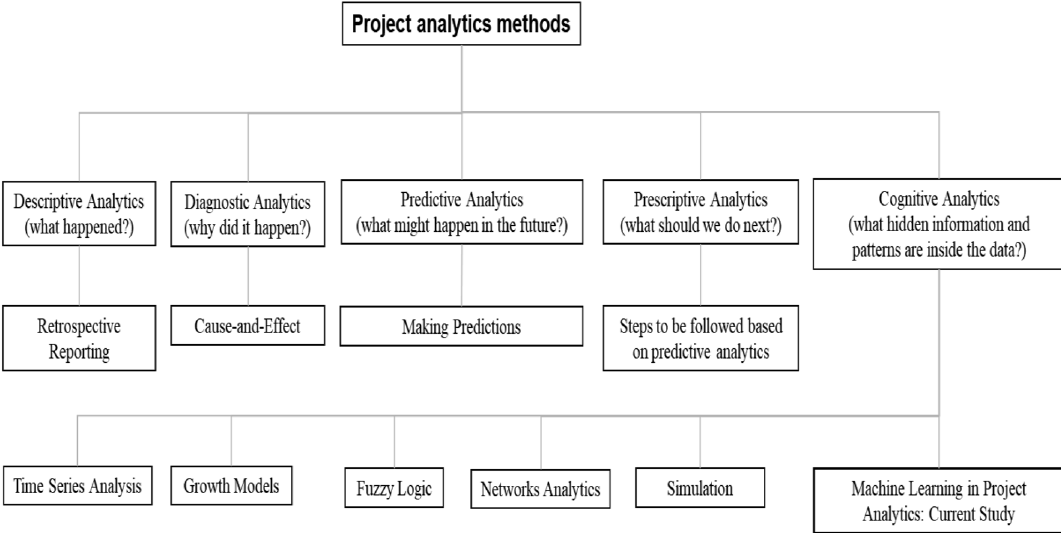
Figure 1. A tree diagram of different project analytics methods. It also shows where the current study belongs to. Although earned value analysis is commonly used in project analytics, we do not include it in this figure since it is used in the first three levels of project